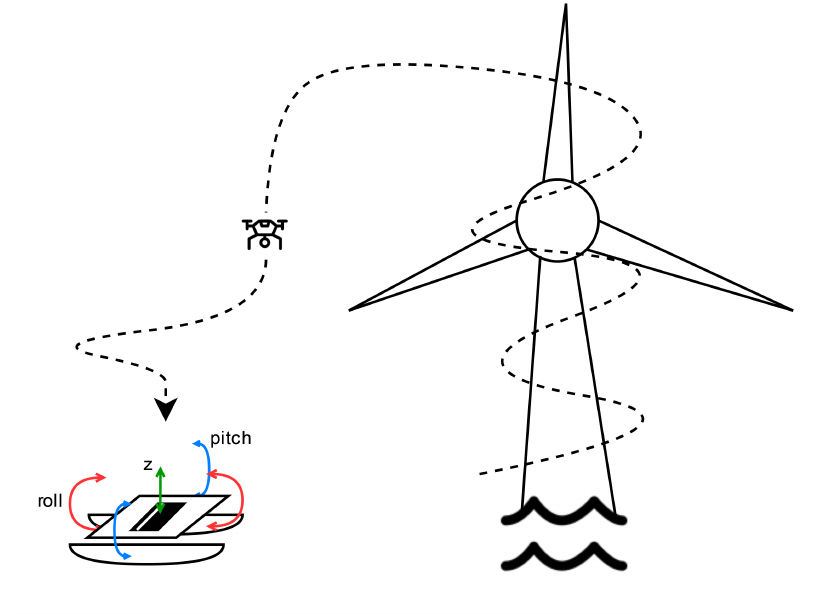
Figure 2. UAV–ASV cooperation for inspection and maintenance of offshore wind turbines. Mission